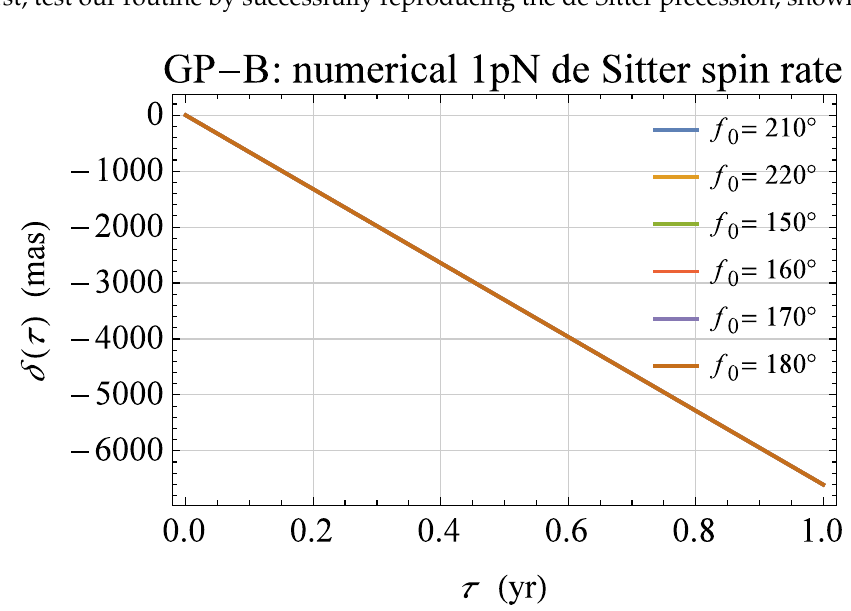
(cid:0) (cid:1) ˆ r for µ / r 2